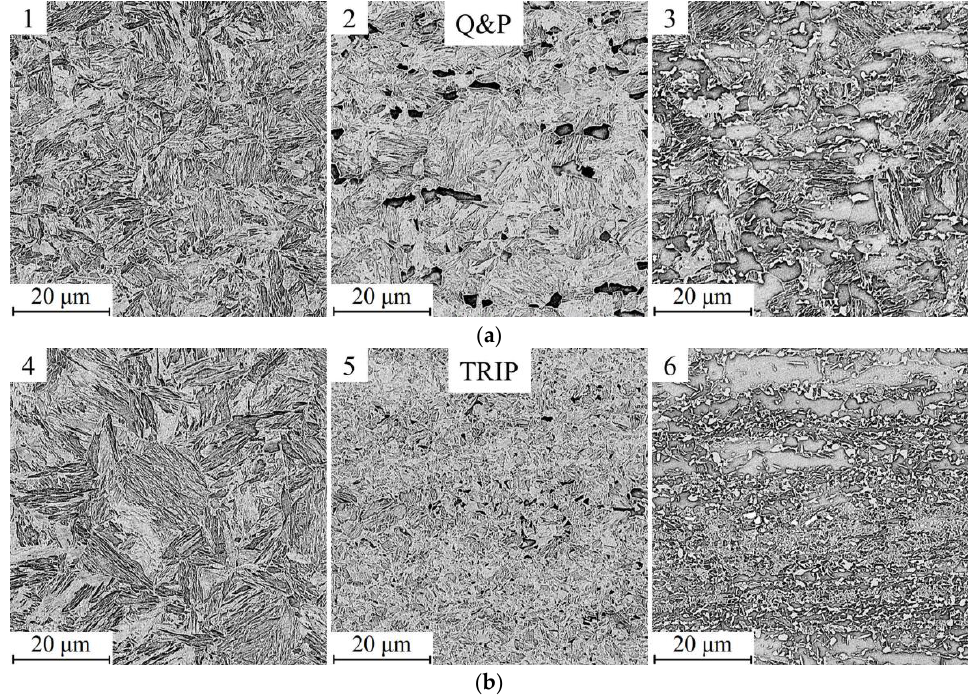
Figure 5. SEM micrographs of the microstructure in the heat affected zones (HAZs) on the ( a ) Q&P and ( b ) TRIP sides: from close to the fusion zone (left-hand images) to the base metals (right-hand images). The numbers from 1 to 6 refer to the locations pointed out in Figure 4.